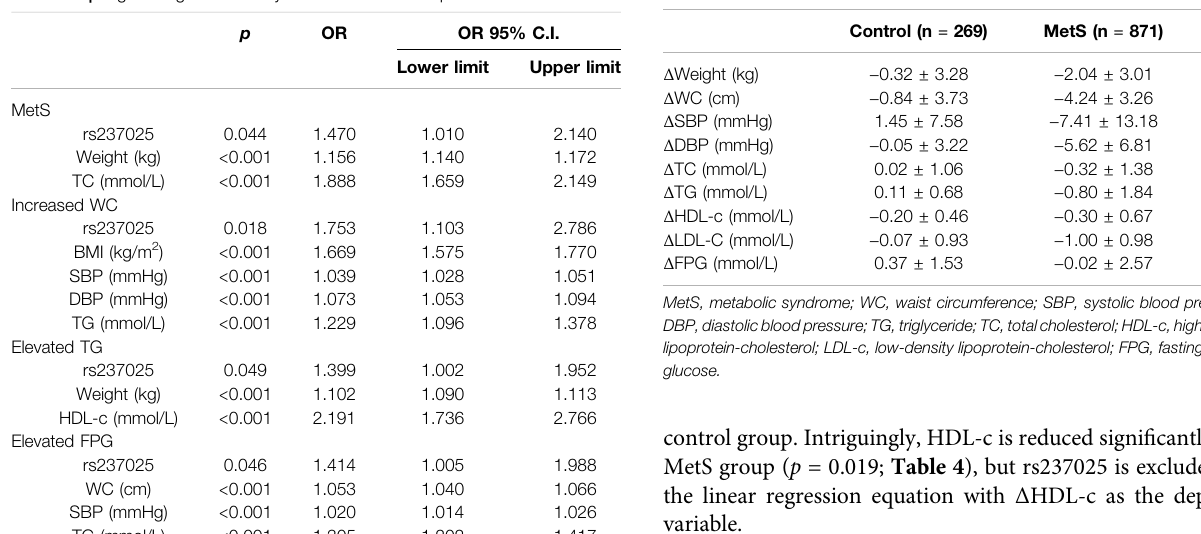
TABLE 3 | Logistic regression analysis of MetS and components of MetS. TABLE 4 | Changes of the MetS related indicators in the follow-up